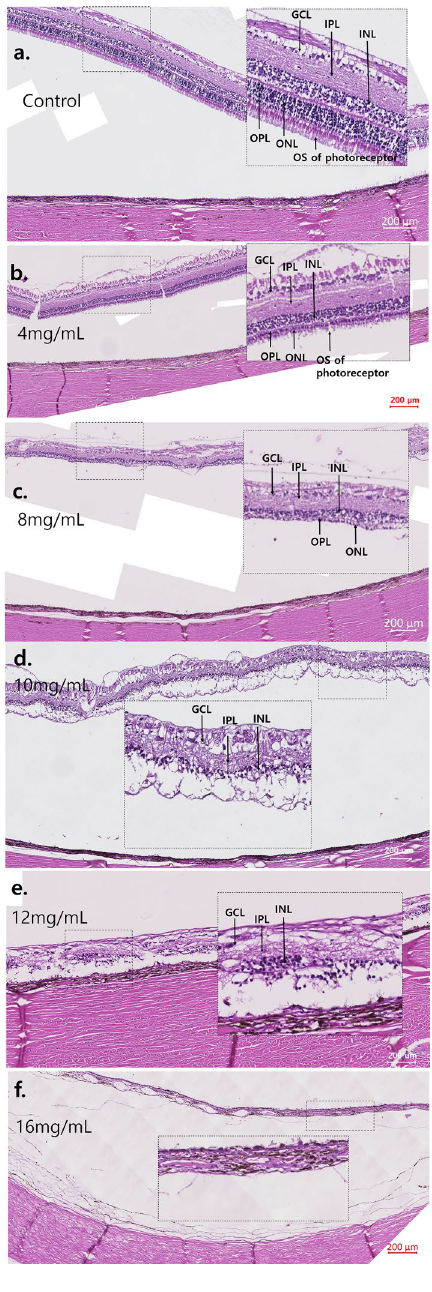
Figure 3. H&E staining image of the retina in cases of 4 mg/mL, 8 mg/mL, 10 mg/mL, 12 mg/mL, and 16 mg/ mL MNU. ( a – f ) Each magnified H&E staining image of the case is on the right-side shown with a dashed-line box. ( a ) H&E staining of the control case. Each count number of ONL, INL, and GCL in dotted enlarged area was 586, 298, and 56, respectively. ( b ) In H&E staining of the 4 mg/mL MNU case, all layers including the INL, GCL, and NFL were nearly intact. However, the thickness of OPL and ONL decreased. ONL (4 nuclear layers) of the 4 mg/mL MNU case is thinner than ONL (7–8 nuclear layers) of control ( a ). Each count number of ONL, INL, and GCL in dotted enlarged area was 247, 285, and 50, respectively. ( c ) In H&E staining of the 8 mg/mL MNU case, the outermost photoreceptors remained to some degree but at severely reduced density. The density of ONL and INL also was reduced, but the GCL was relatively intact. Each count number of ONL, INL, and GCL in dotted enlarged area was 43, 216, and 40, respectively. ( d ) In H&E staining of the 10 mg/mL MNU case, ONL cells were rarely observed among INL or combined INL with ONL cells. Each count number of ONL, INL, and GCL in dotted enlarged area was 0, 87, and 16, respectively. ( e ) In H&E staining of the 12 mg/mL MNU case, ONL cells were rarely observed among INL or combined INL with ONL cells. Each count number of ONL, INL, and GCL in dotted enlarged area was 0, 74, and 15, respectively. ( f ) In H&E staining of the 16 mg/ mL MNU case, proliferative vitreoretinopathy and retinal detachment were observed, and the entire layer was extremely thin. MNU N -methyl- N -nitrosourea, GCL ganglion cell layer, IPL inner plexiform layer, INL inner nuclear layer, OPL outer plexiform layer, ONL outer nuclear layer, OS outer